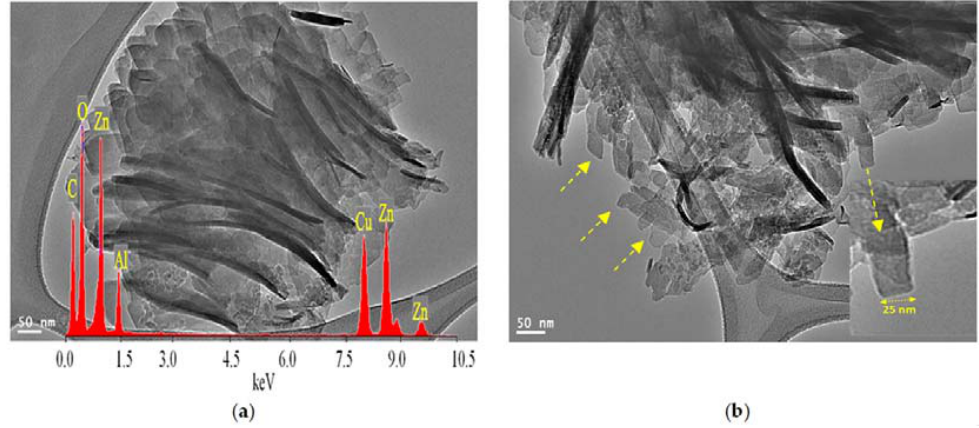
Figure 5. Sample ZA ‐ 3: ( a ) TEM images (inset: EDX spectrum) and ( b ) TEM images in another lo ‐ Figure 5. Sample ZA-3: ( a ) TEM images (inset: EDX spectrum) and ( b ) TEM images in another cation.